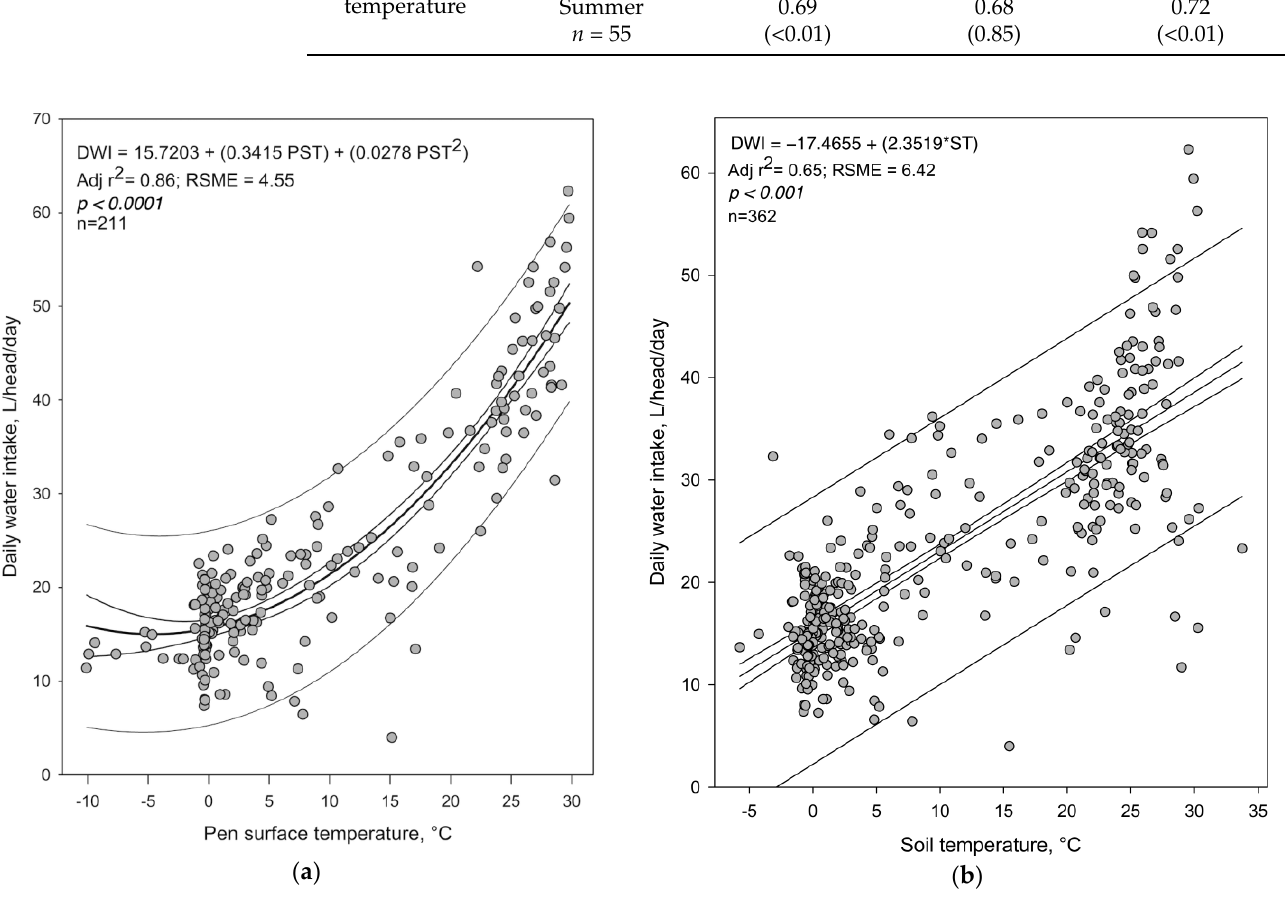
Figure 1. Relationship of daily water intake (DWI) and pen surface temperature (PST) with best fitting equations for ( a ) the overall model (May to October) and for ( b ) the summer model (June to August.